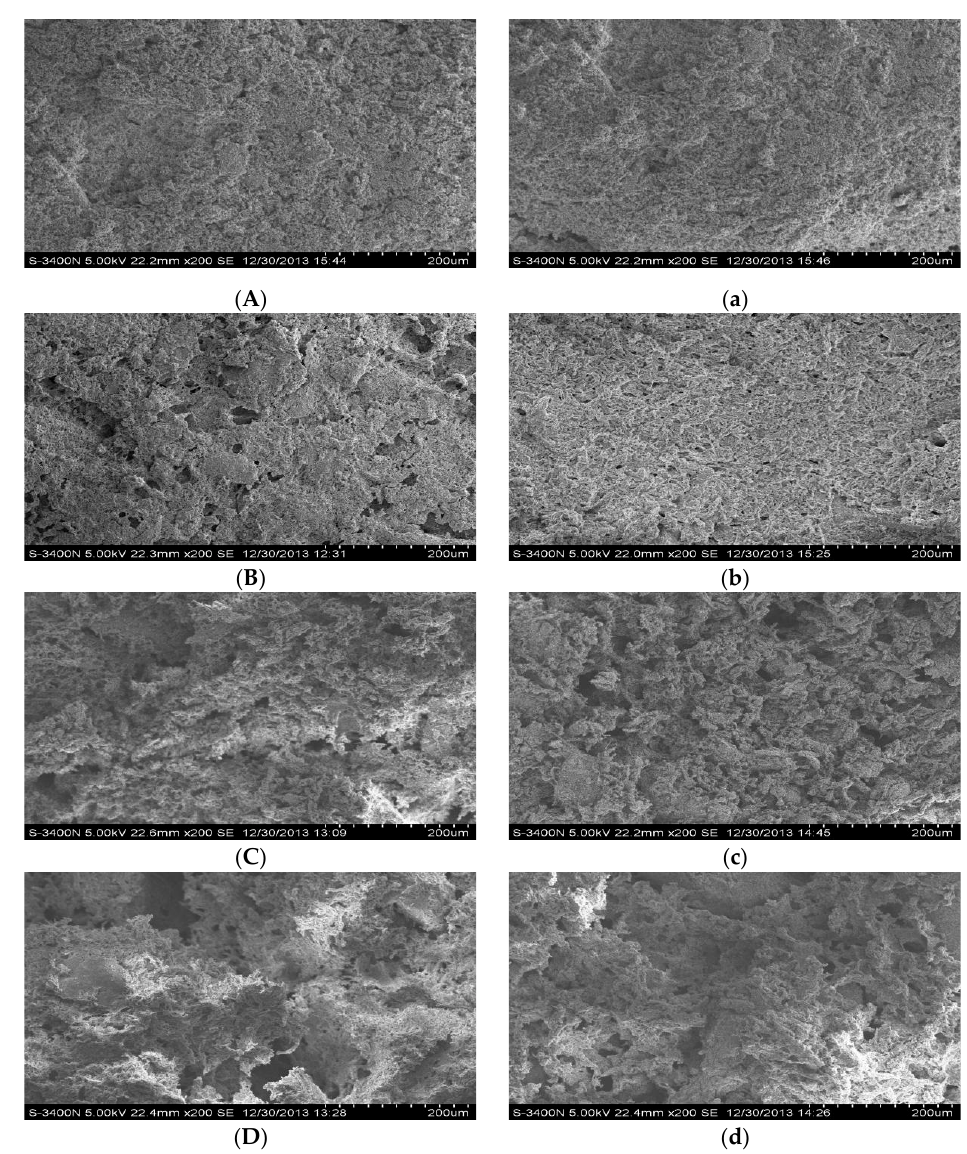
Figure 7. Electron micrographs of CE in the MPs gel at different oxidation times (Magnification 200×). ( A ) Non-oxidized; ( B ) oxidized for 1 h; ( C ): oxidized for 3 h; ( D ) oxidized for 5 h; ( a ) contains 1.0 mg/mL CE non-oxidized; ( b ) contains 1.0 mg/mL CE oxidized for 1 h; ( c ) contains 1.0 mg/mL CE oxidized for 3 h; ( d ) contains 1.0 mg/mL CE oxidized for 5 h.